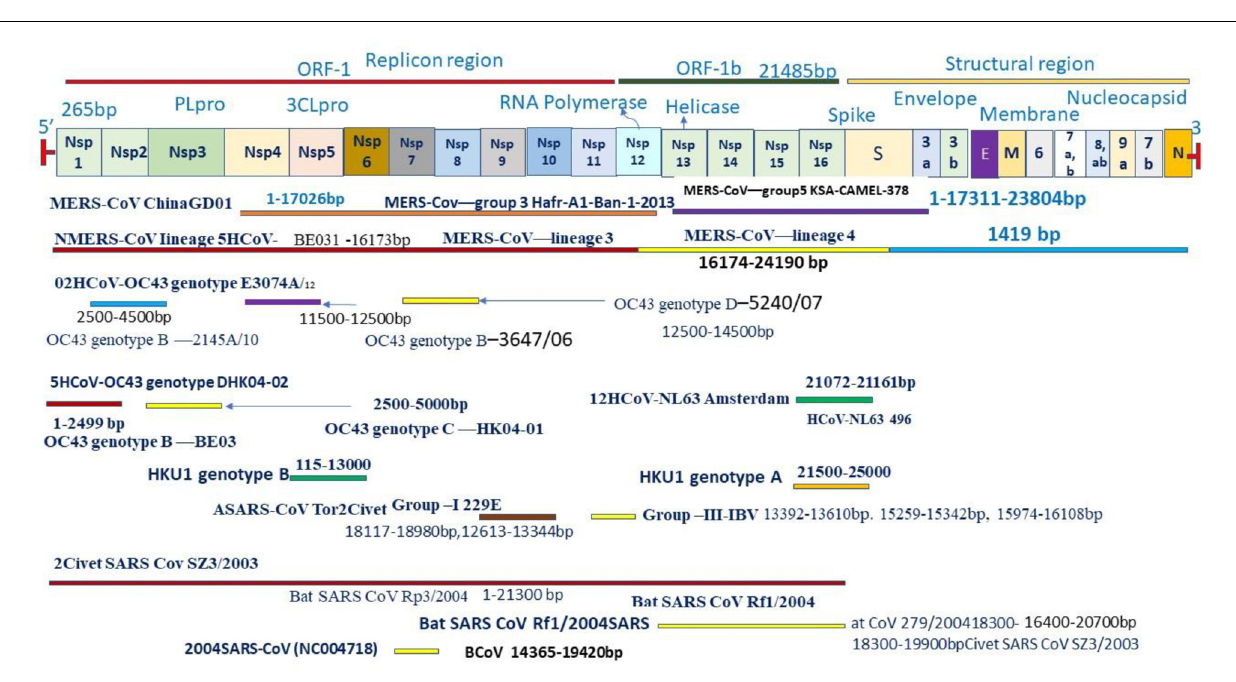
FIGURE 2 | Genome and genetic shift at genomic site coronavirus with zoonotic